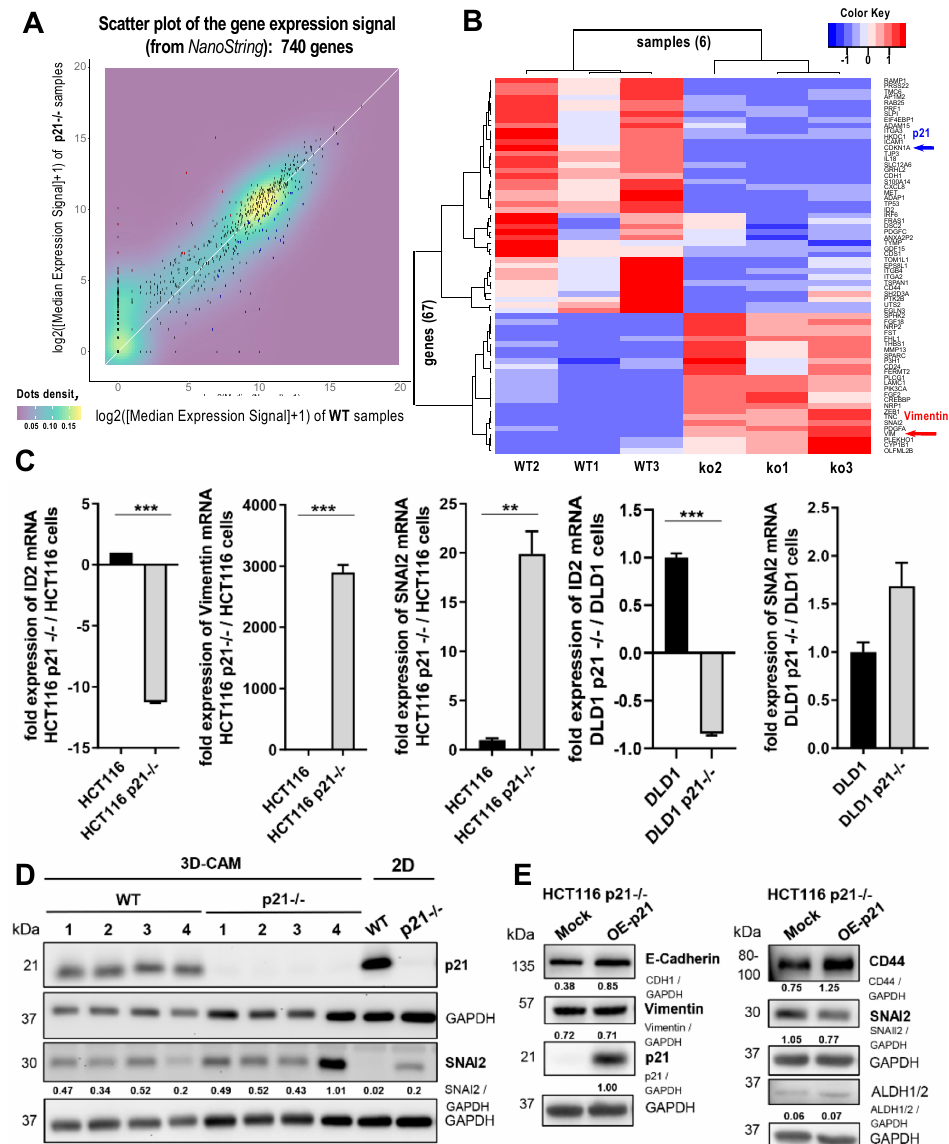
Figure 2. Differential expressions of colon cancer HCT116 WT versus p21-/- cells. ( A ) Scatter plot of the global expression signal. ( B ) Heatmap presenting the expression profiles of the 67 genes selected, in terms of the most significant differential expression changes found. Gene CDKN1A (*p21 protein) was not expressed in knockout samples, and gene VIM (vimentin) was a marker that was not expressed in WT samples. ( C ) Fold changes of expression ID2, VIM, and SNAI2 in HCT116 and DLD1 p21-/- cells when compared to WT cells, as determined by qPCR (** p -value < 0.01, *** p -value < 0.001, n = 3; biological triplicate and technical triplicate). ( D ) Western blot analysis of p21 and SNAI2 in CAM xenografts derived from HCT116 WT and HCT116 p21-/- cells ( n = 4) and 2D culture ( n = 2). Fold expressions are represented relative to GAPDH loading control. ( E ) Western blot analysis of p21 over-expression (OE) in HCT p21-/- cells to investigate EMT and stemness markers ( n = 2). Fold expressions are presented relative to GAPDH loading control.